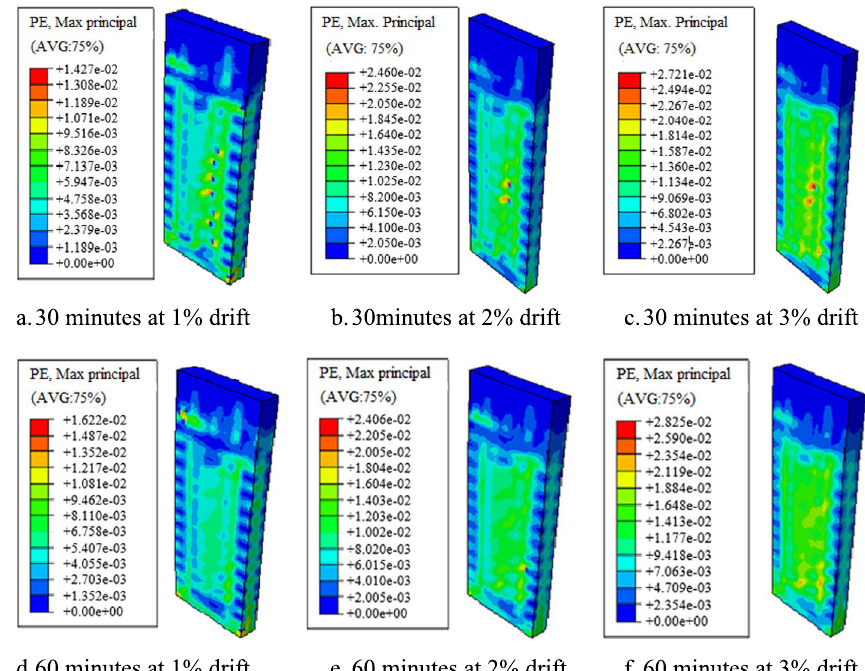
Fig. 47 Distribution of crack for different durations of fire exposure. a 30 min at 1% drift. b 30 min at 2% drift. c 30 min at 3% drift. d 60 min at 1% drift. e 60 min at 2% drift. f 60 min at 3% drift